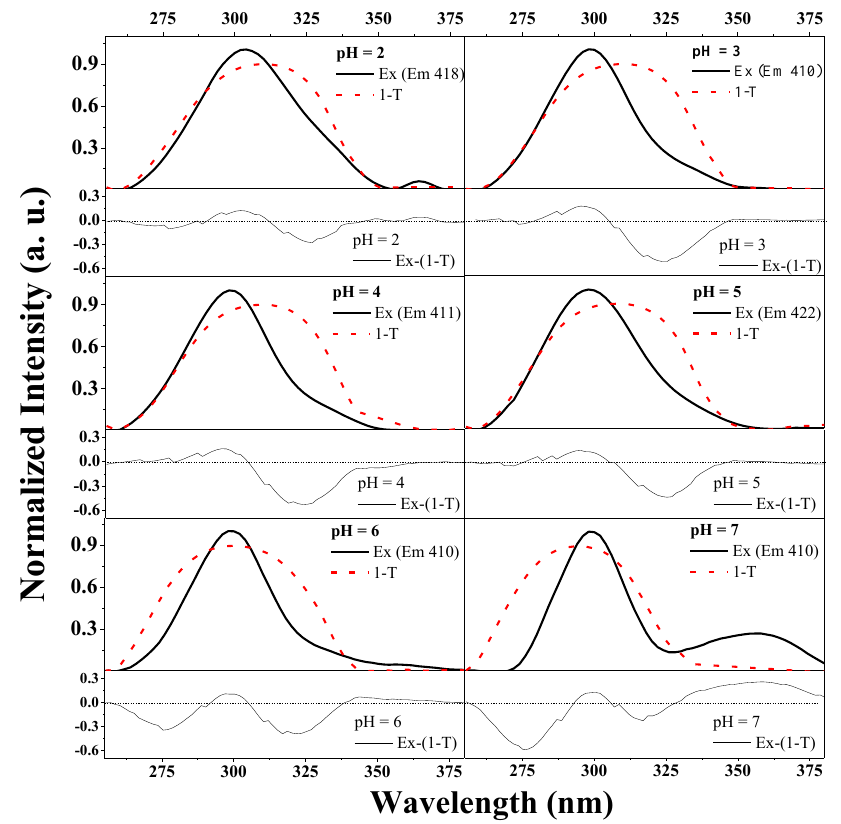
Figure 5. Fluorescence excitation spectra normalized at the maximum (to the value of 1) in comparison with 1-T spectra (T: transmission) of TS dissolved in H 2 O at different pH (from 2 to 7). Below, the respective differential spectra Ex-(1-T) corresponds to the spectra in the panels above.